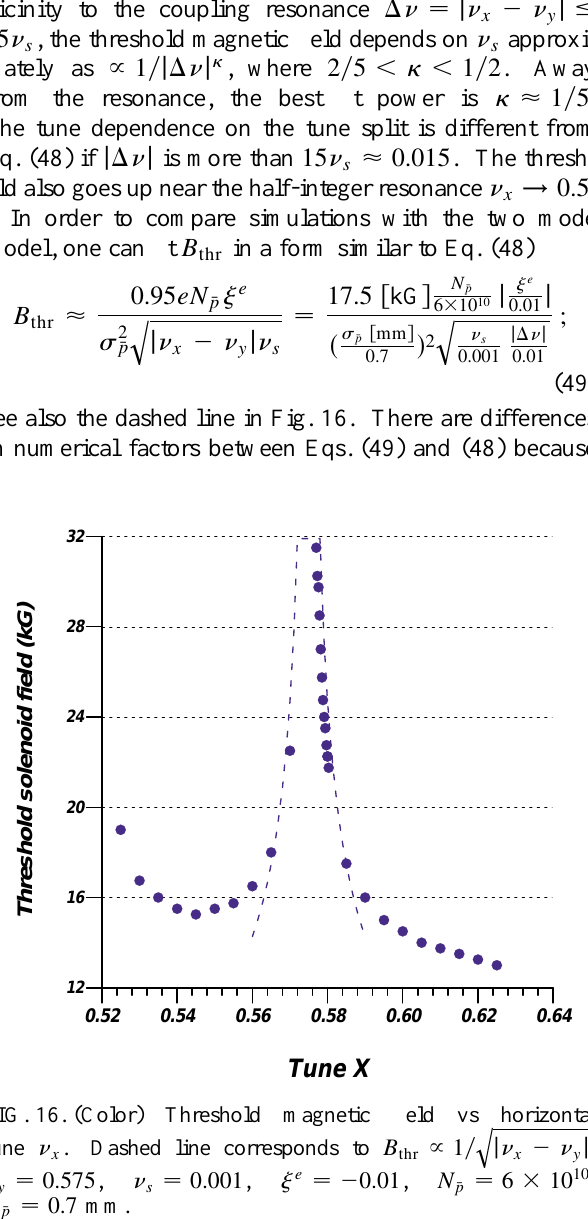
q j n j x 2 n y